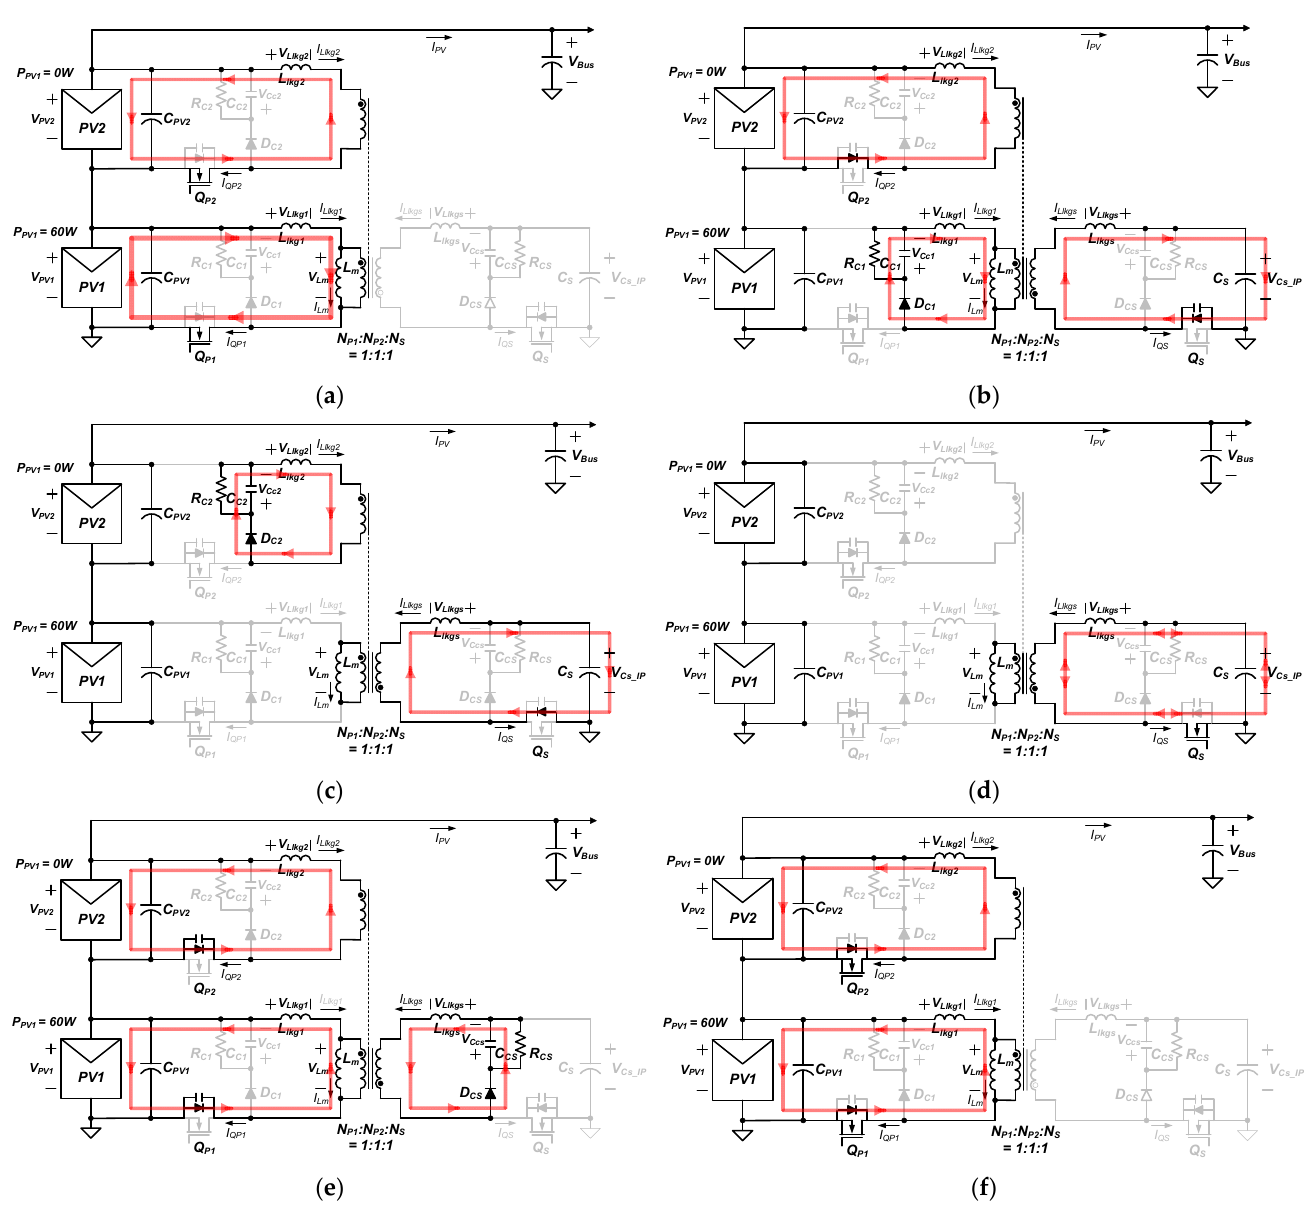
Figure 4. Operational mode of the DPP. ( a ) Mode 1 ( t 0 – t 1 ). ( b ) Mode 2 ( t 1 – t 2 ). ( c ) Mode 3 ( t 2 – t 3 ). ( d